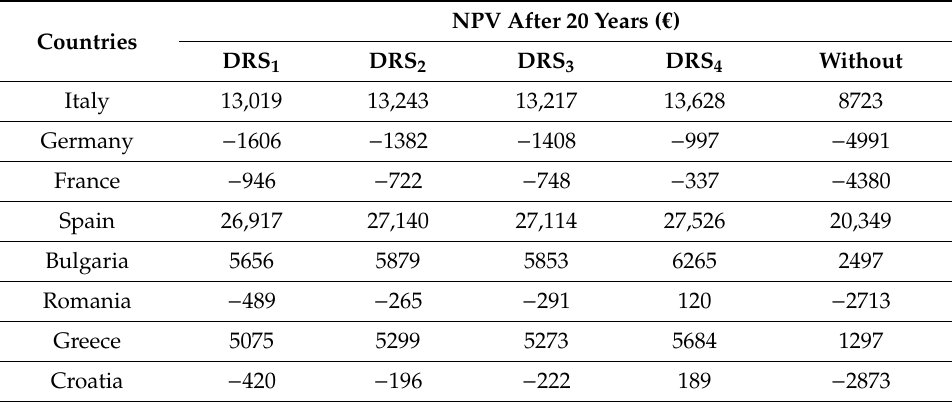
Table 17. NPV values after 20 years (increment power 20%).